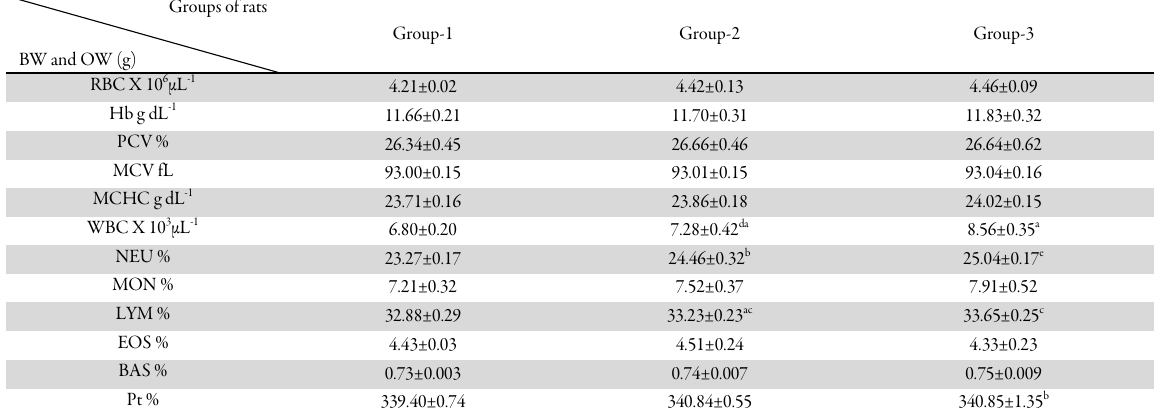
Table 8. Effect of SNPs on hematological profile rats treated with vehicle and SNPs 200 and 400 mg/kg. n=5±SE of mean, a=p<0.05,